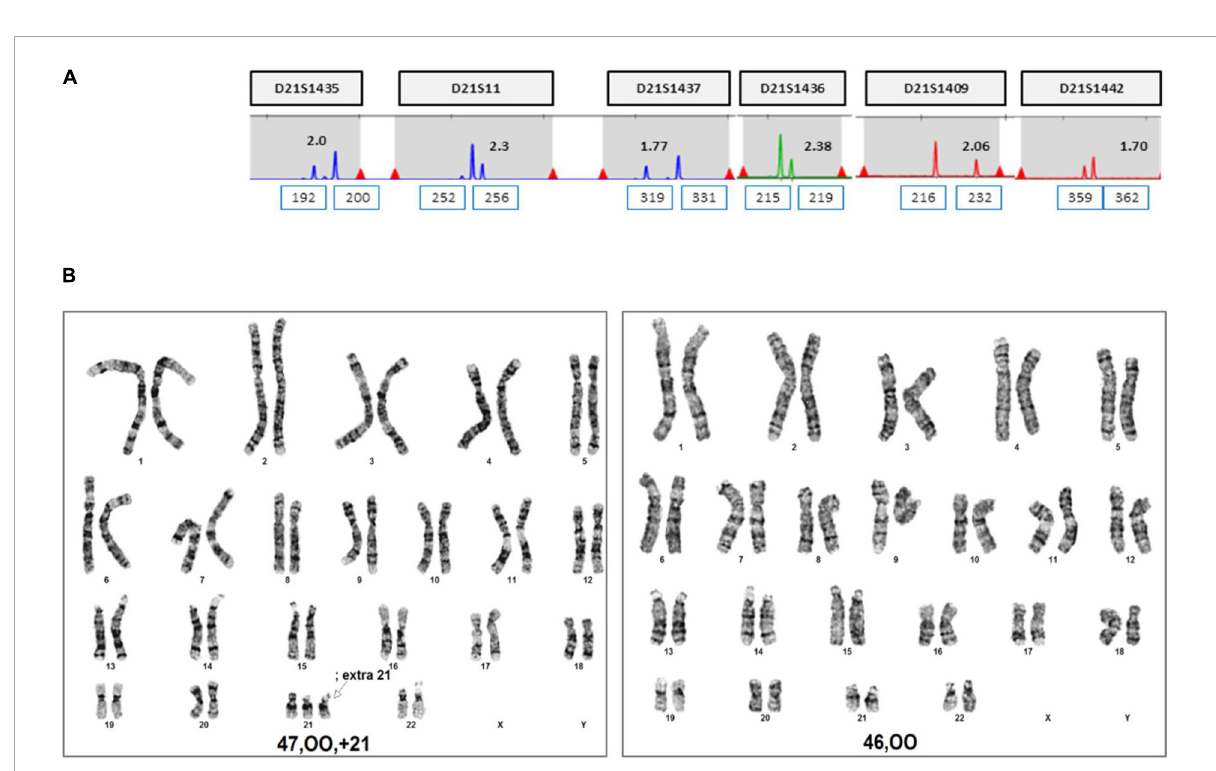
FIGURE6 QF-PCR and conventional karyotyping results in case 2. (A) QF-PCR result for chromosome 21 of uncultured amniocytes. (B) Conventional karyotype analysis of cultured amniocytes; 47, OO, +21[22]/46, OO